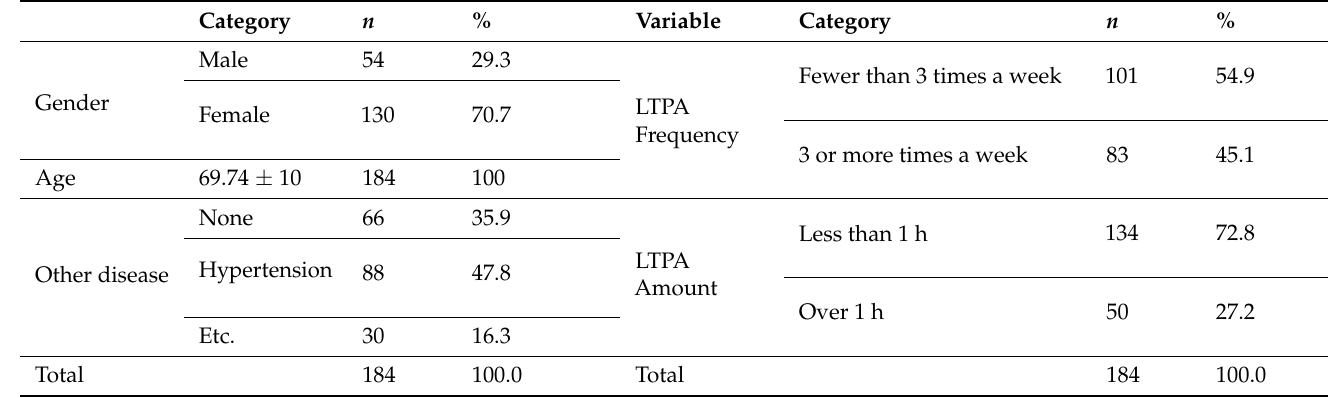
Table 3. Demographic characteristics for the pre-diabetes-elderly-only